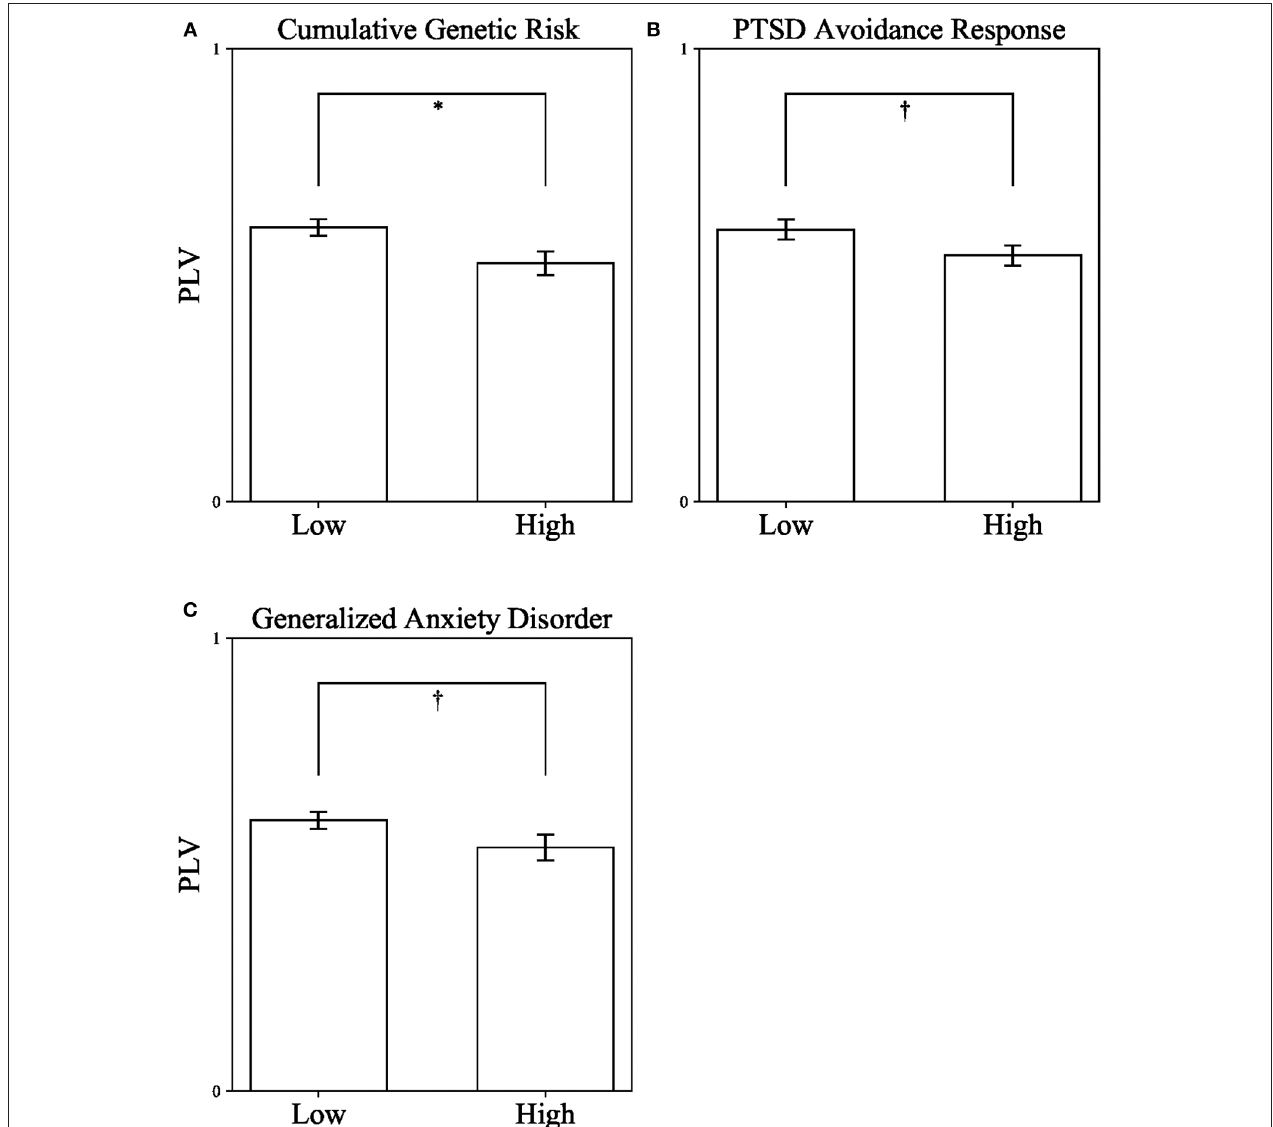
FIGURE 3 | Differences in DMN connectivity (PLV) from a series of independent t -tests between children with high and low Cumulative Genetic Risk on Oxytocin-Pathway Genes (A) , PTSD Avoidance Response in Early Childhood (B) , and Generalized Anxiety Disorder in Late Childhood (C) . PLV, Phase locking value. * p < 0.05; † p < 0.1. Error bars represent standard